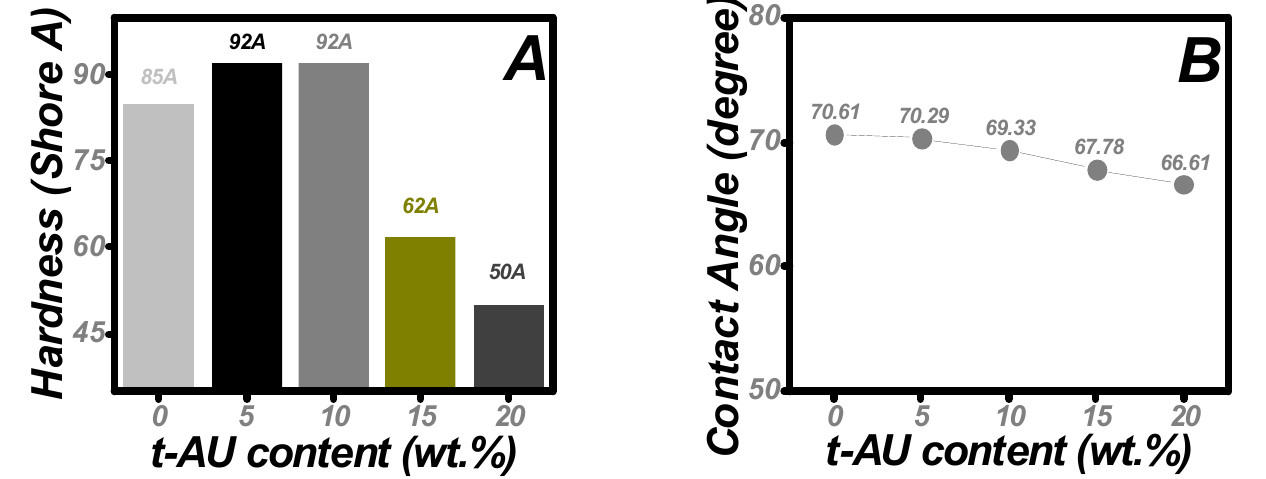
Figure 6. Hardness ( A ) and contact angle ( B ) of AUP series as a function of t-AU content.